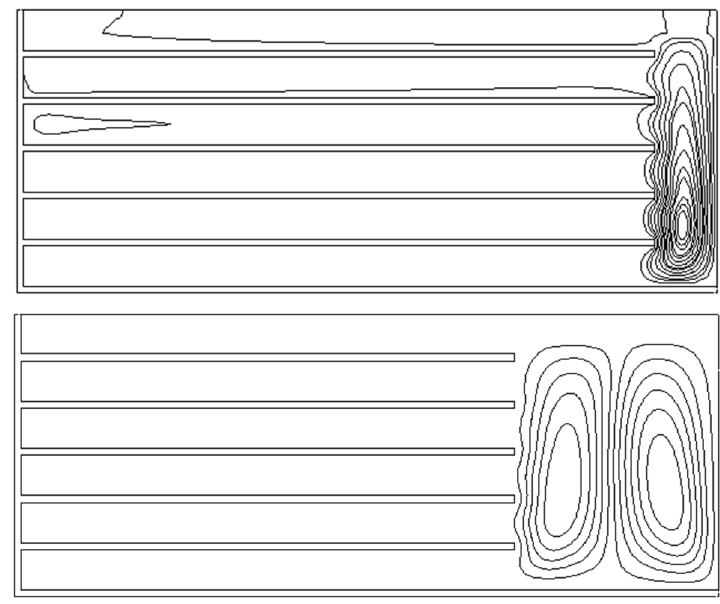
Figure 11. Streamlines at LR = 0.7 and LR = 0.9 ( H = 10 mm, n = 5, AR = 5).